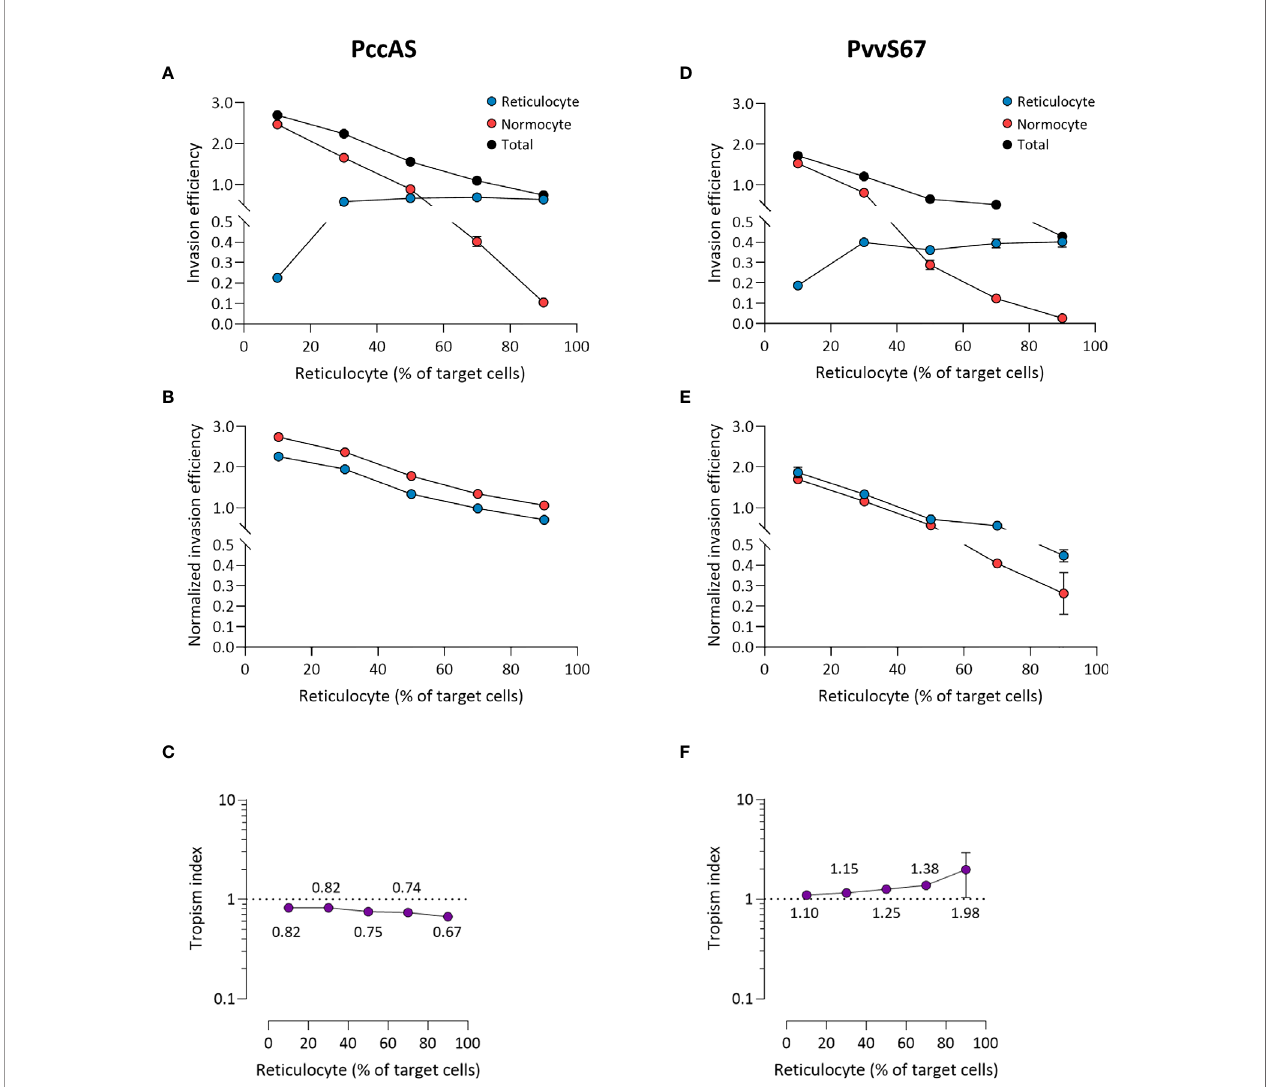
FIGURE 6 | Ex vivo tropism of P. chabaudi chabaudi AS (A – C) and P. vinckei vinckei S67 (D – F) at variable reticulocyte:normocyte ratios. (A, D) Reticulocyte (blue) and normocyte (red) invasion ef fi ciencies (see Materials and Methods for calculation) were compared at fi ve different erythrocyte ratios, 10:90, 30:70, 50:50, 70:30, 90:10 reticulocyte:normocyte. Total invasion ef fi ciency (black) is the sum of reticulocyte and normocyte invasions. (B, E) Reticulocyte and normocyte invasion ef fi ciencies were normalized to their respective population frequencies (see Materials and Methods ). (C, F) Tropism indices were calculated from the ratio of normalized reticulocyte invasion ef fi ciency to the normalized normocyte invasion ef fi ciency. Mean tropism indices are also shown. Dotted lines at tropism index = 1 represent mixed tropism. All error bars represent standard deviation. n = 5 technical replicates, for each